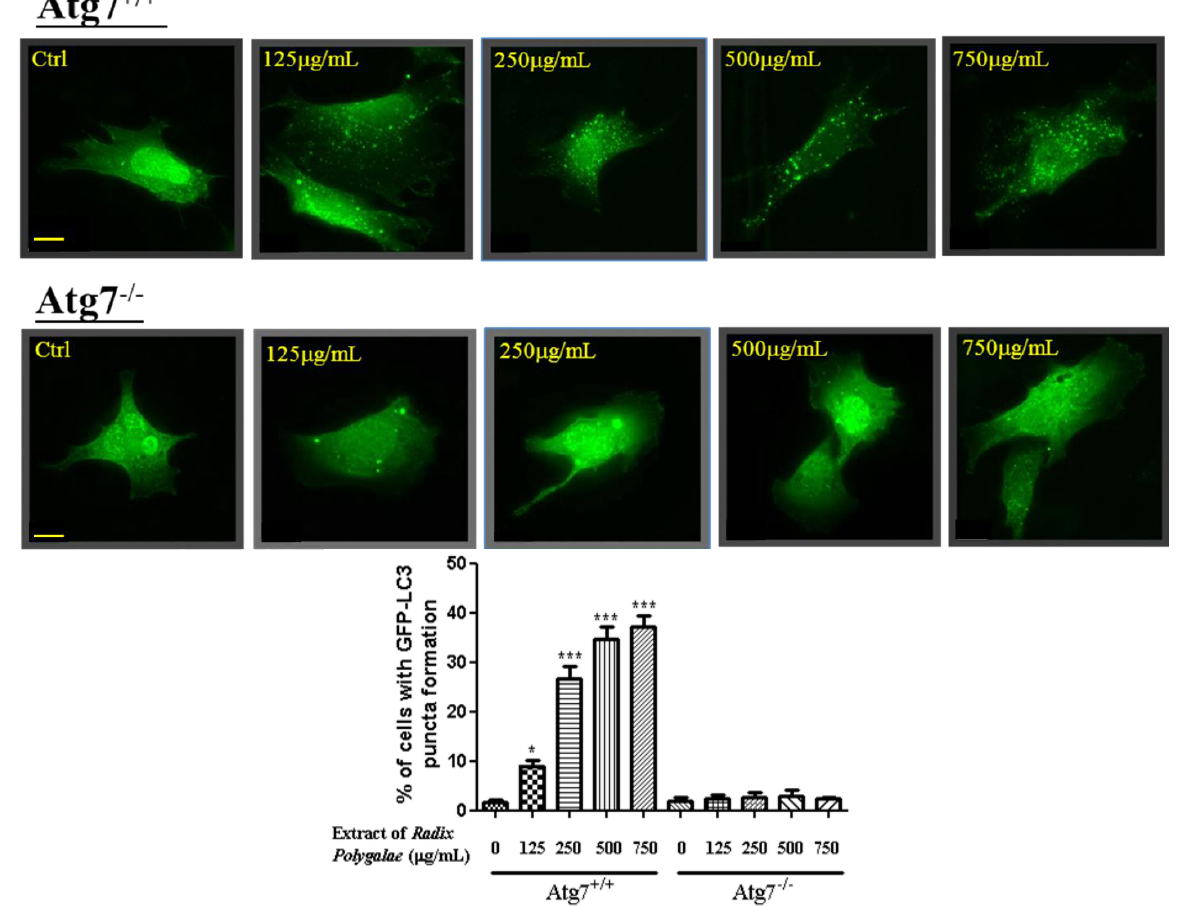
Figure 2. Ethanol extracts of Radix Polygalae induce autophagy via an Atg 7 dependent mechanism. Wild type Atg 7 and Atg 7-deficient MEF cells transiently transfected with GFP-LC3 were treated with Radix Polygalae ethanol extracts at the indicated concentrations for 24 h. Bottom: bar chart represents the percentage of cells with GFP-LC3 puncta formation. Magnification, ×40. *** p < 0.001; * p < 0.05. Scale bar: 15